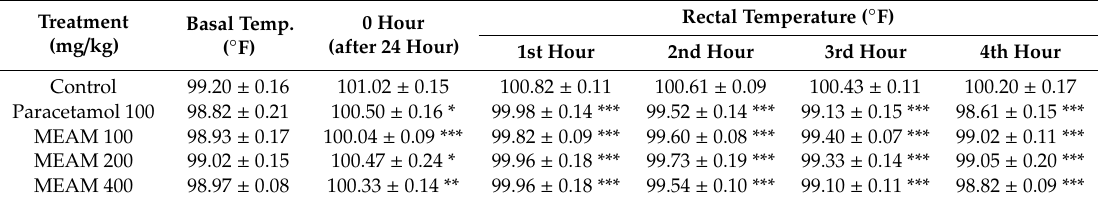
Table 5. Antipyretic e ff ect of methanol extract of A. montanum (MEAM) on Brewer’s yeast induced pyrexia in